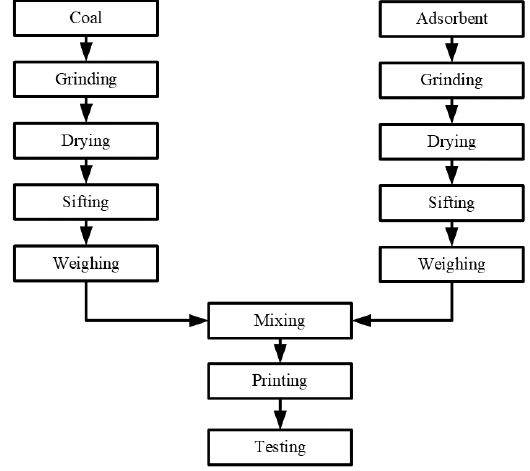
Figure 2. Diagram for material process Table 3. Types of research tools and their respective